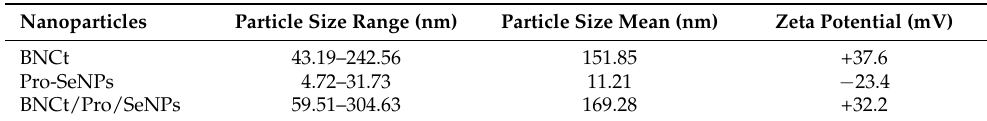
Table 1. Nanoparticles’ size and charges of fabricated bee nanochitosan (BNCt), propolis-synthesized SeNPs (Pro-SeNPs) and their nanocomposites (BNCt/Pro/SeNPs).